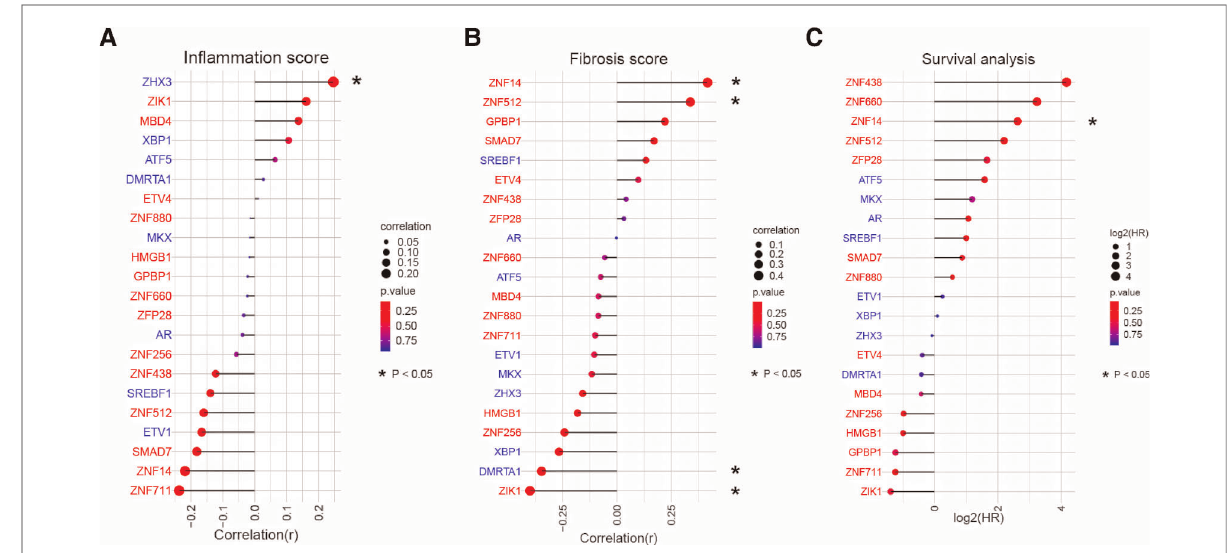
FIGURE 4 Correlation analysis between TFs expression and liver pathology/patient survival in BA. ( A ) Relationship between TFs expression and liver in fl ammation grade in BA liver. TFs were ranked according to the strength of the correlation ( − 1<r<1). The point size and line length represented the strength of the correlation. The color represented the p value. ( B ) Relationship between TFs expression and liver fi brosis grade in BA liver. TFs were ranked according to the strength of the correlation ( − 1<r<1). The point size and line length represented the strength of the correlation. The color represented the p value. ( C ) Cox regression for patient survival. TFs were ranked according to log2(HR). The point size and line length related to log2 (HR). The color represented the p